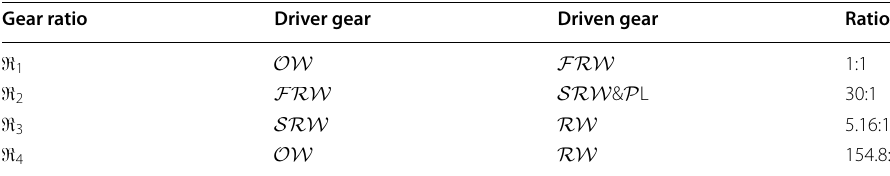
Table 1 Gear ratio Gear ratio Driver gear Driven